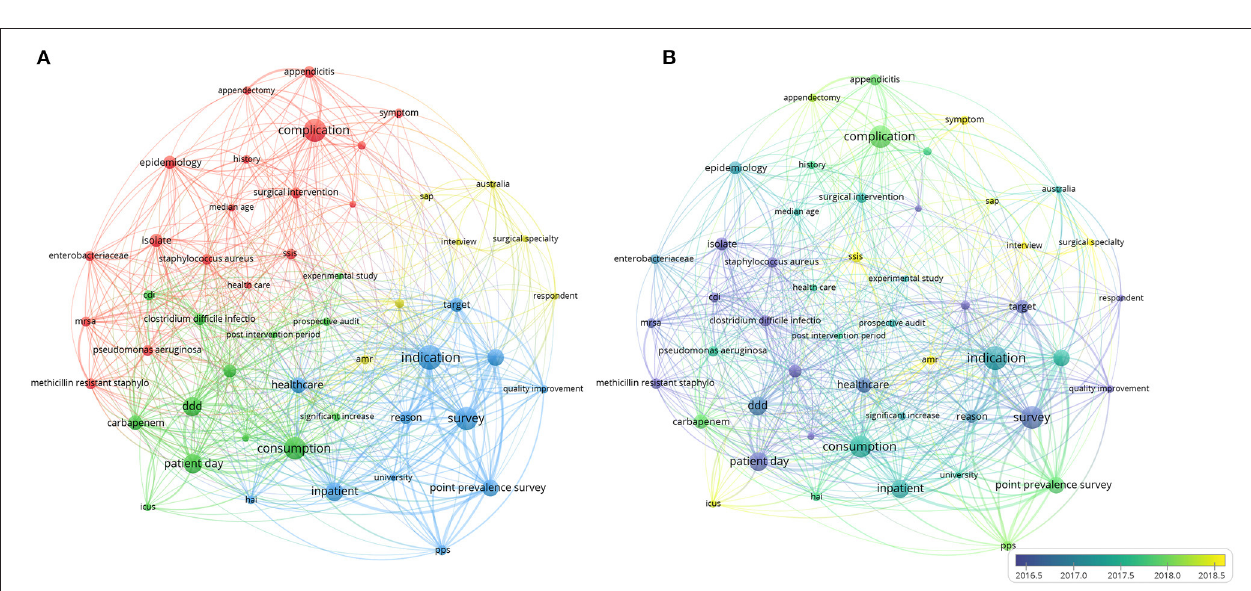
AMS management in surgery. The phenomenon